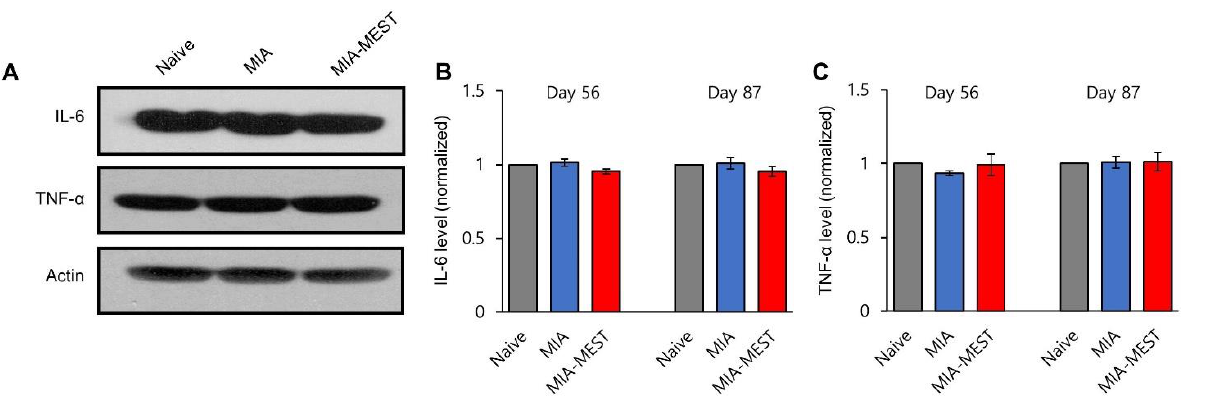
Figure 5. MEST does not affect the local amount of pro-inflammatory cytokines. Representative band images on day 87 ( A ). IL-6 and TNF- α levels in RFM on days 56 and 87 ( B , C ). N = 3 per group. Data are presented as mean ± 95% confidence intervals.